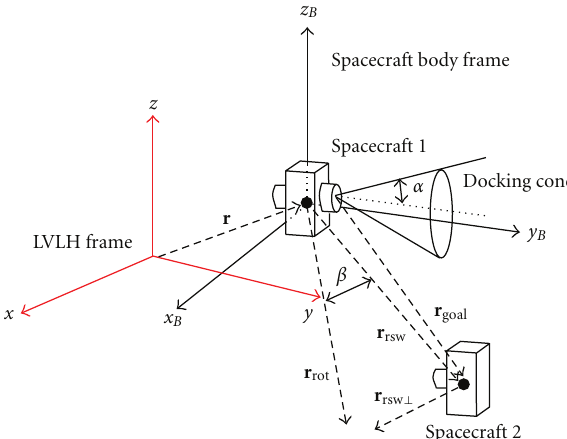
Figure 7: Relative vectors used in the alignment and assembly logic. All vectors are in the LVLH xy